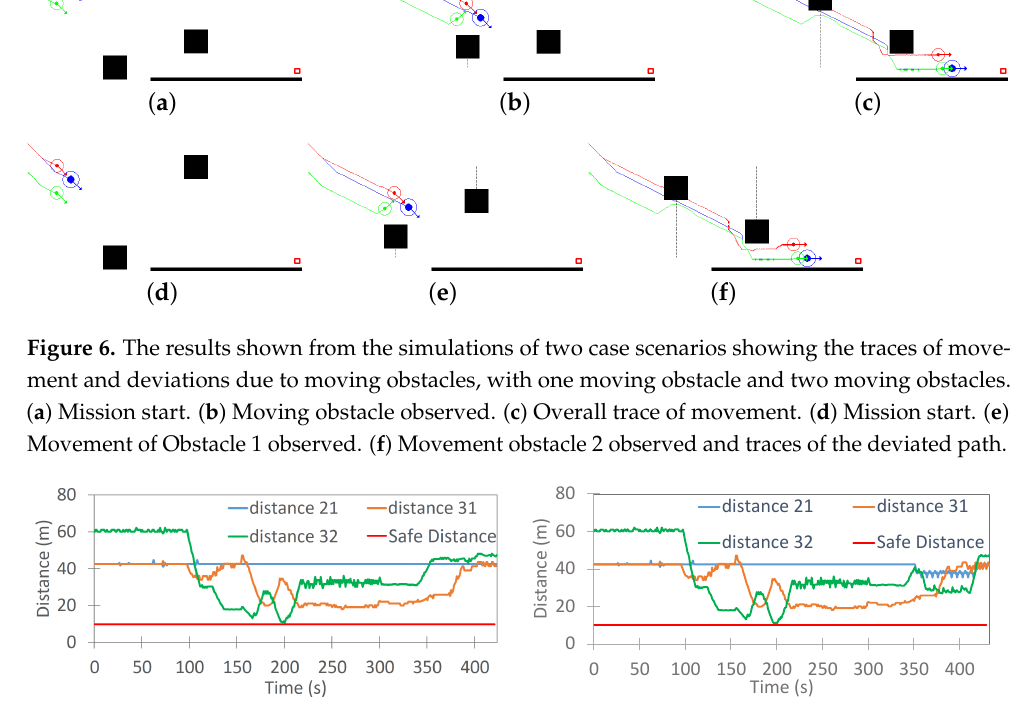
( a ) With one moving obstacle Figure 7. Distance maintained by each agent from its neighbour.